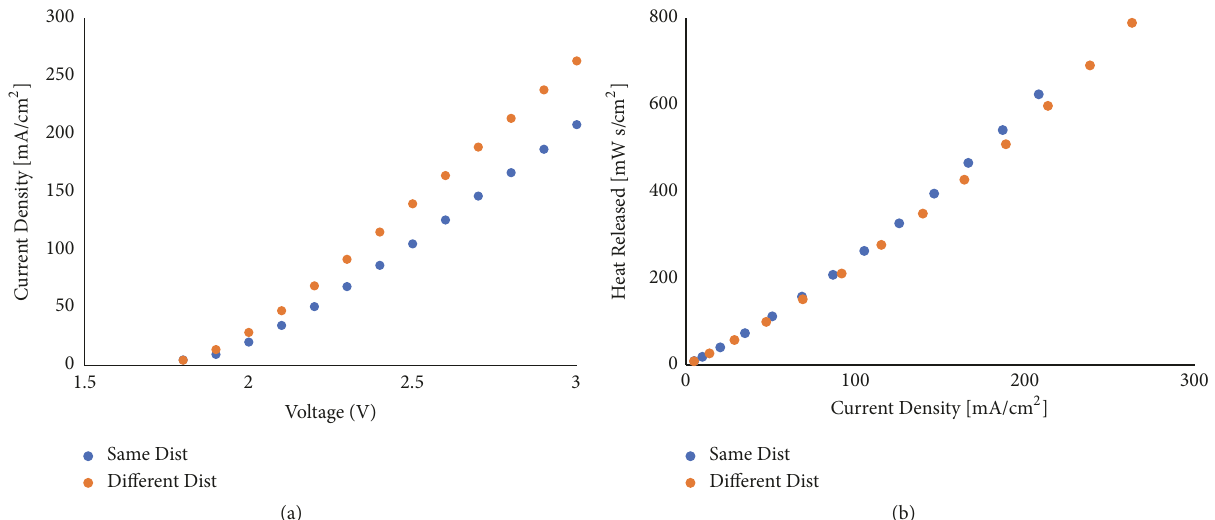
Figure 4: (a) Polarization curves per unit area for the same distance between electrodes and with different distances between the cathode and anode electrodes with respect to the separator and (b) heat released as a function of current density for the same systems.